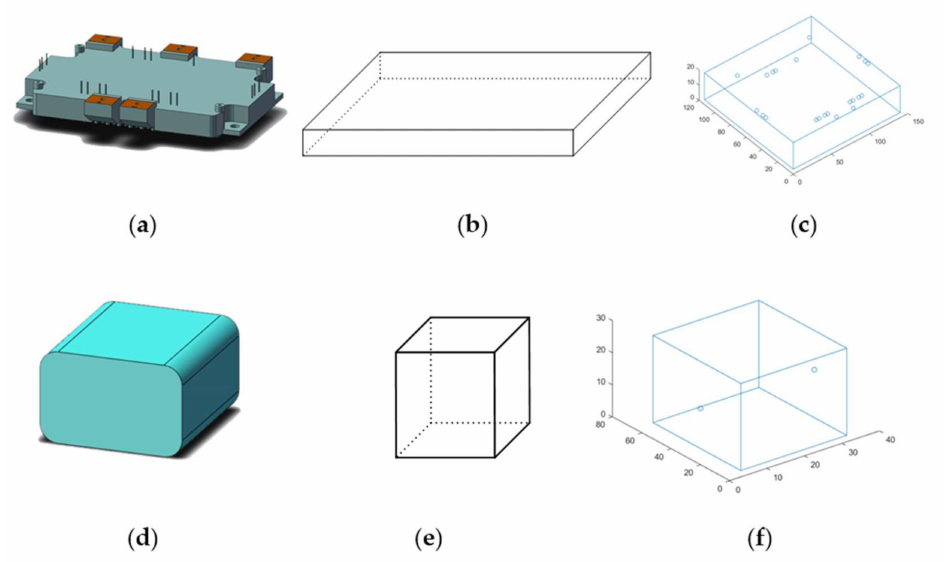
Figure 2. ( a ) Power module, ( b ) The equivalent cube of the power module, ( c ) A model of a power module and its connecting terminals in a program, ( d ) Capacitor core, ( e ) The equivalent cube of a capacitor core, ( f ) The model of the capacitor core and its connecting terminals in the